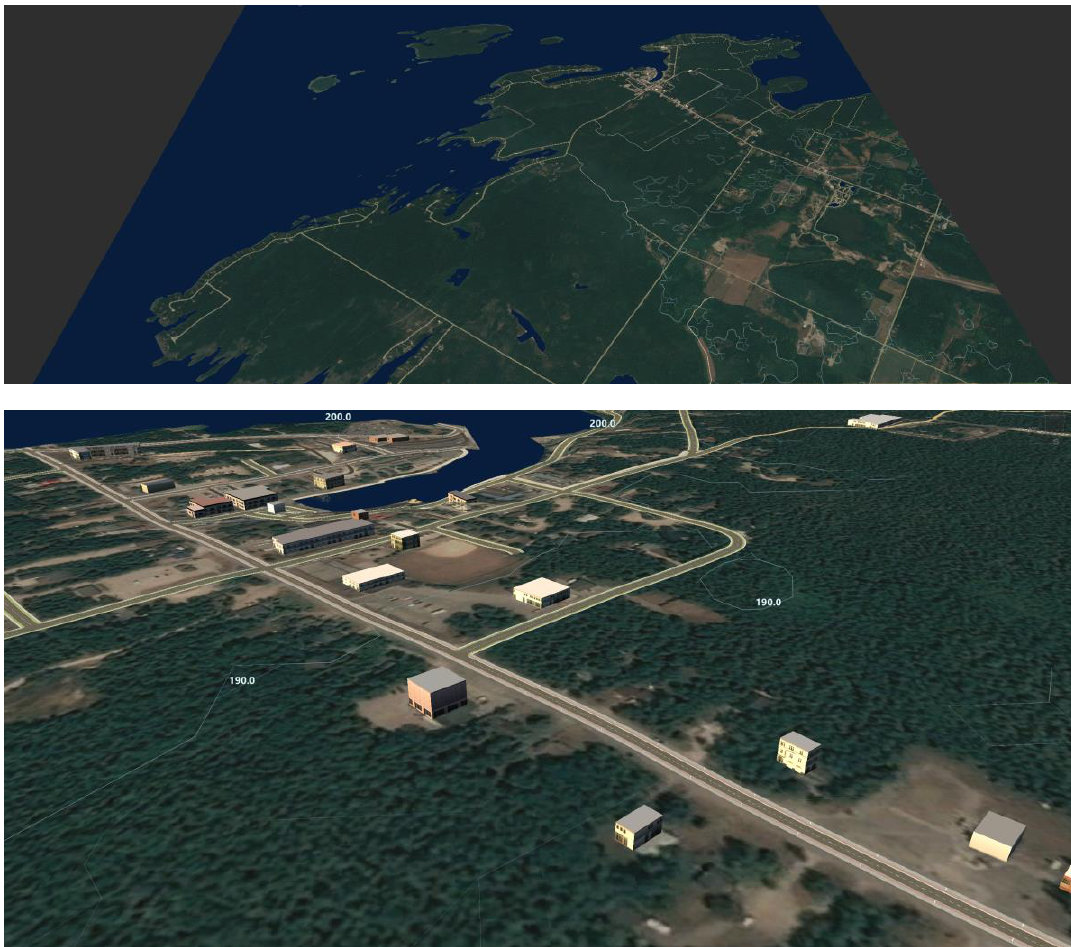
Figure 9. Some images of Proposal 1, which was generated using online repositories accessed with Model Builder ® in Autodesk InfraWorks ® (AIF). Top: an overall view of the whole area. Bottom: an example showing the level of detail for the BIM-GIS model.